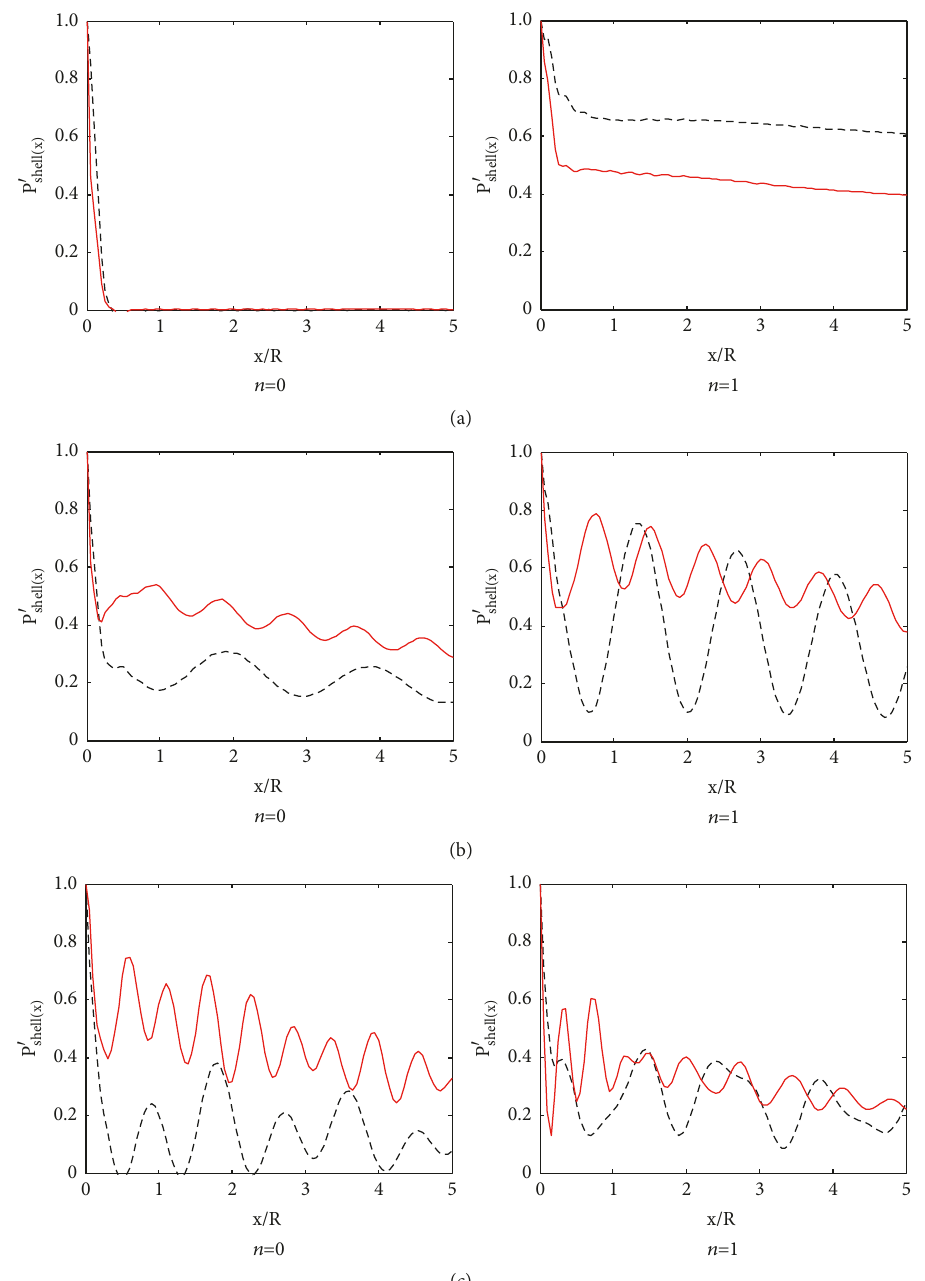
Figure 10: The comparison of power transmitted by the shell with 𝐸 2 /𝐸 1 =15: (a) Ω = 0.3 , (b) Ω = 1.2 , and (c) Ω = 3.0 ; black dashed line: 𝐸 /𝐸 = 15 ; red solid line: 𝐸 11 22